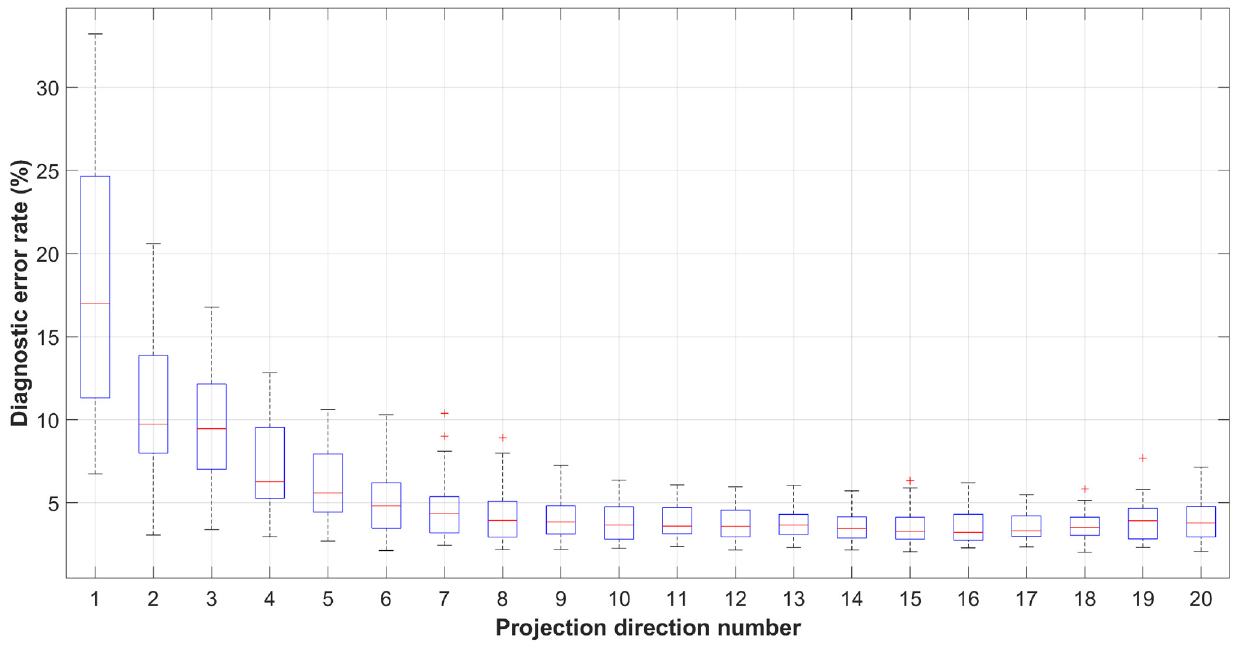
Fig 10. Diagnostic error rates with different PLS projection direction